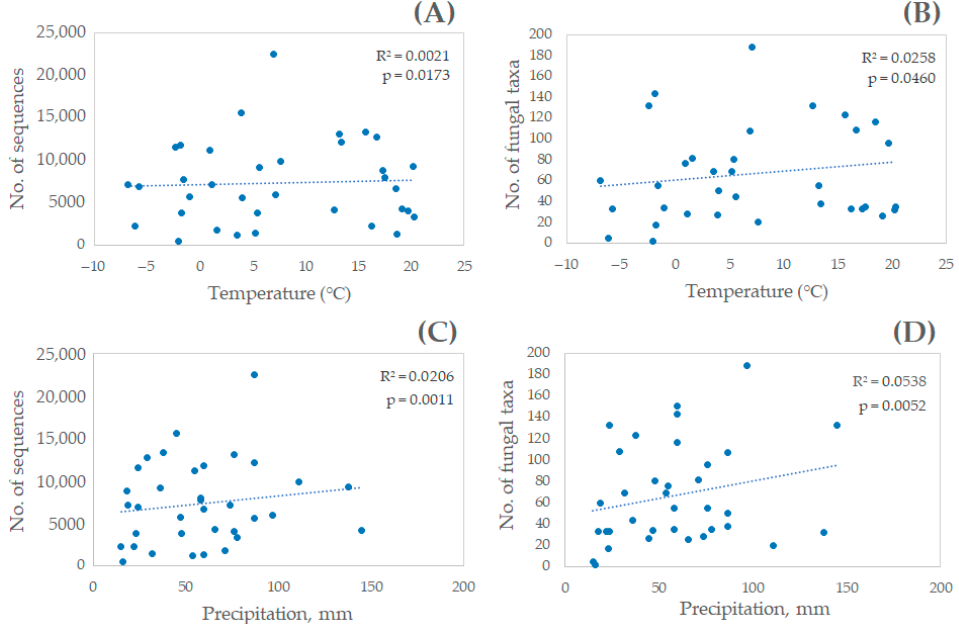
Figure 7. Plots of correlation analysis: ( A ) sequence reads vs. temperature; ( B ) fungal taxa vs. temperature; ( C ) sequence reads vs. precipitation; ( D ) fungal taxa vs. precipitation. The data from all sites are combined.